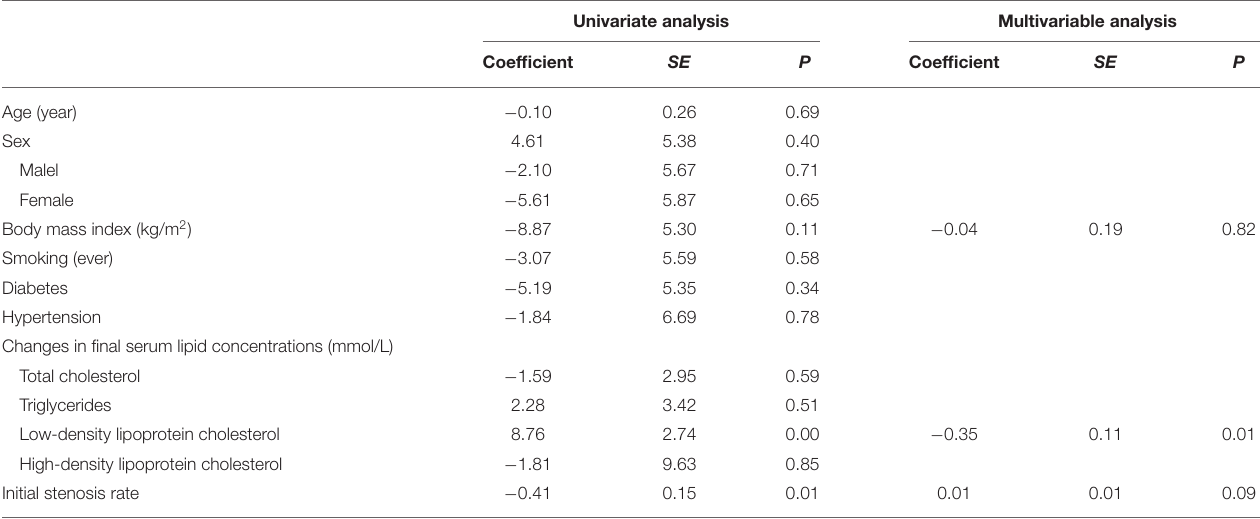
TABLE 5 | Univariate and multiple linear regression analysis of plaque burden changes in vessel wall magnetic resonance imaging (VWMRI). Univariate analysis Multivariable